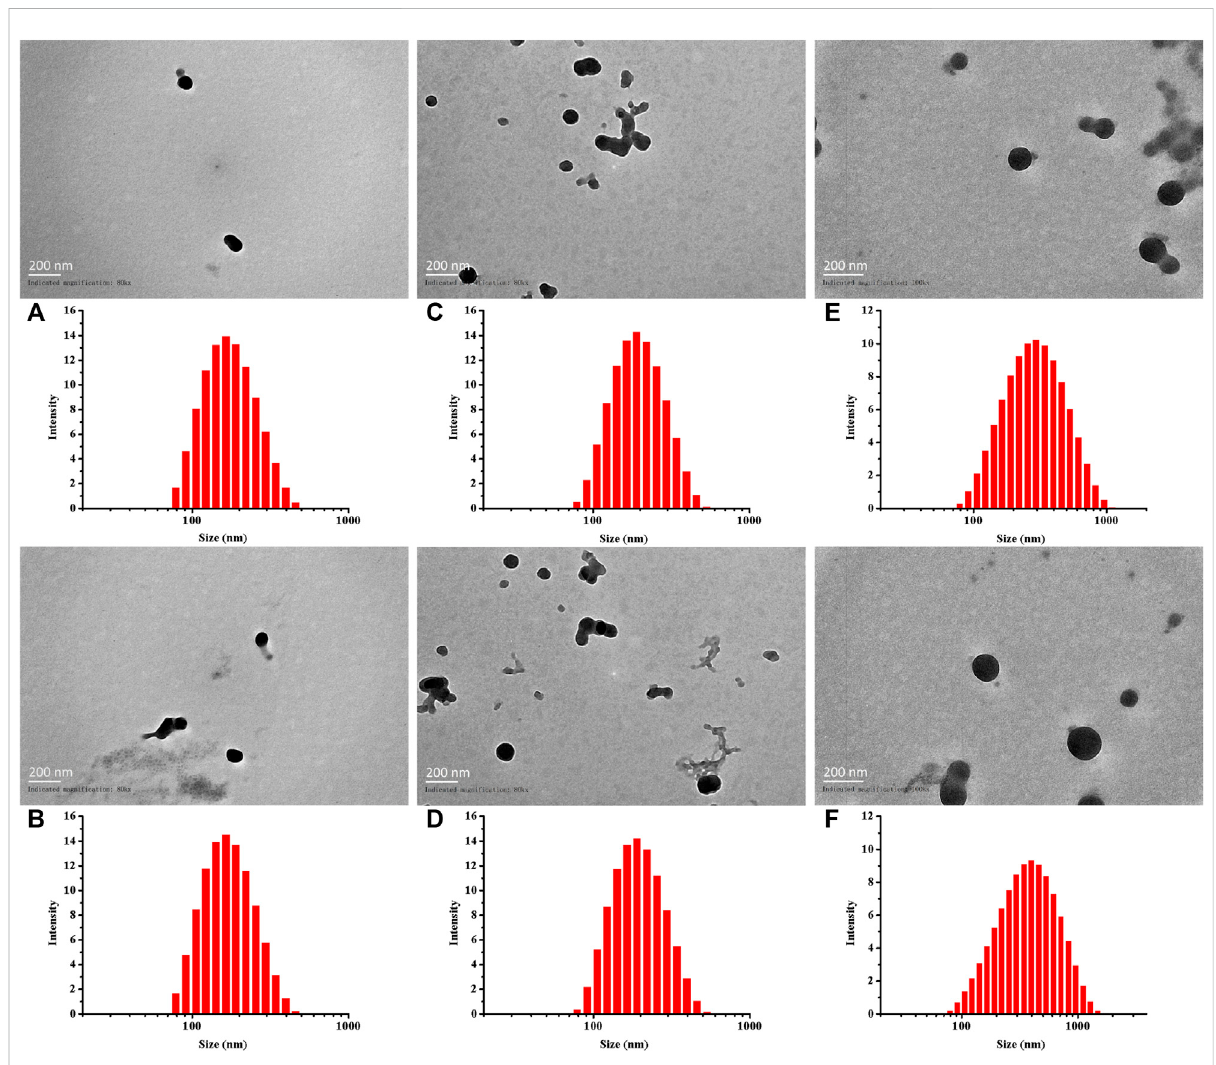
FIGURE 2 Size distribution and TEM images of (A,C,E) Cy5-labeled Oxi- α CD NPs and (B,D,F) Cy5-labeled cRGD-Oxi- α CD NPs: (A,B) 150 – 160 nm, (C,D) 180 – 190 nm, and (E,F) > 220